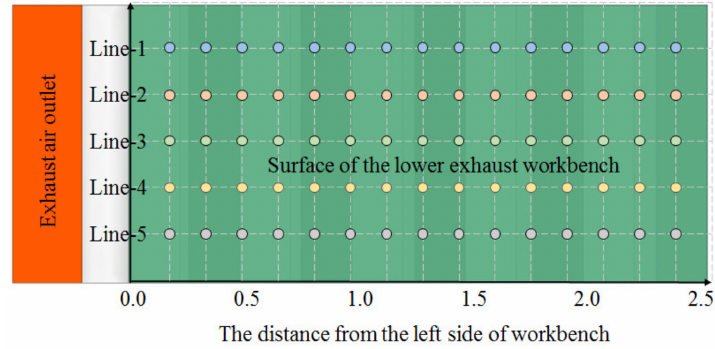
Figure 7. Layout of velocity measure points at the surface of the workbench.